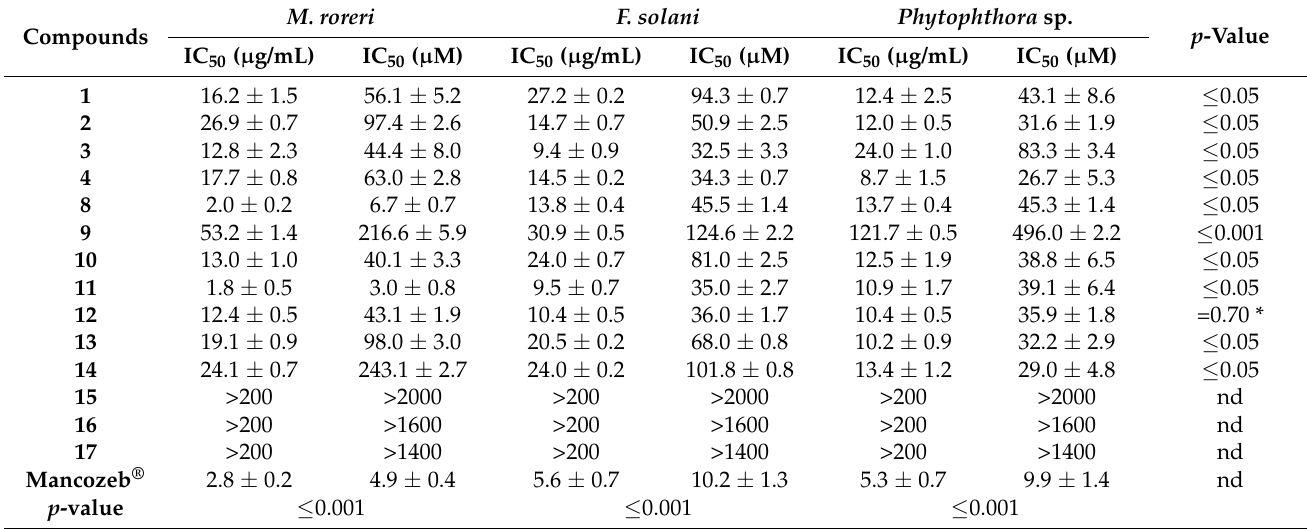
Table 1. Antifungal activity of chemical constituents from P. pesaresanum and its derivatives. M. roreri F. solani Phytophthora Compounds